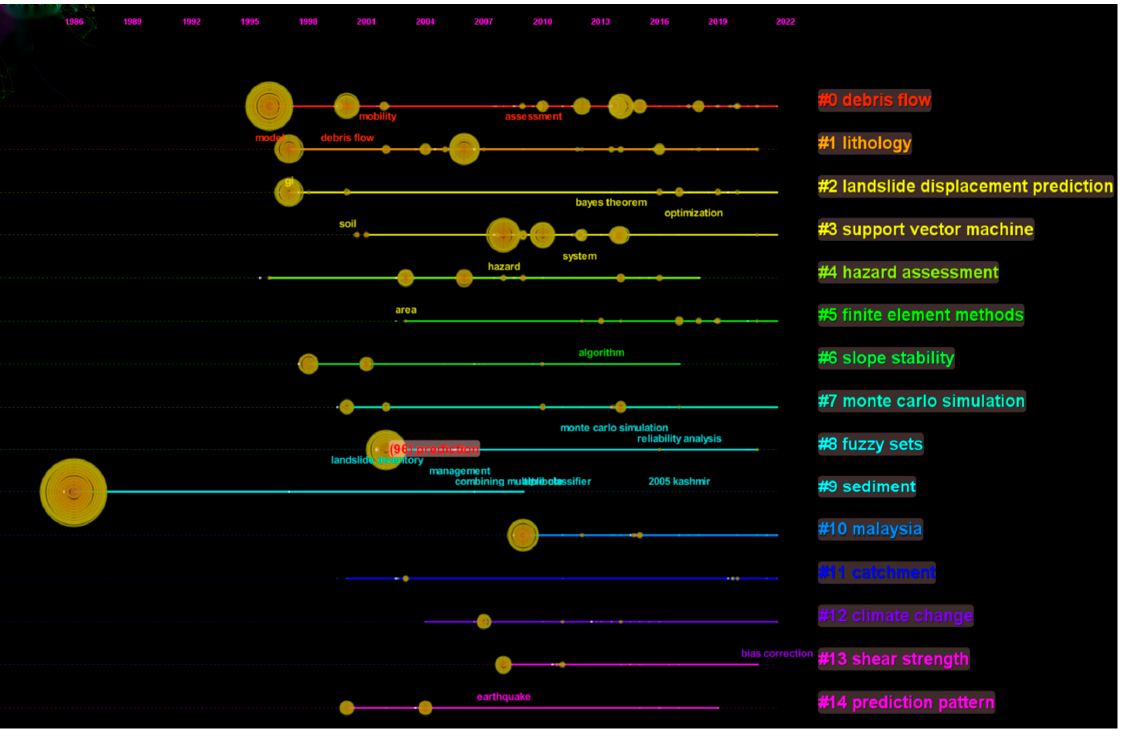
Figure 13. Timeline diagram based on LSR algorithm.